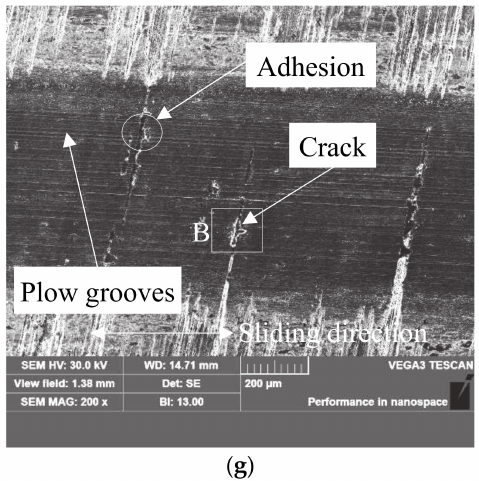
Figure 8. SEM images of the worn surfaces of plasma-nitrided AISI H11 specimens tested at: ( a ) 50 N / 83.3 mm · s − 1 / 298 K, ( b ) 100 N / 83.3 mm · s − 1 / 298 K, ( c ) 150 N / 83.3 mm · s − 1 / 298 K, ( d ) 100 N / 16.7 mm · s − 1 / 298 K,